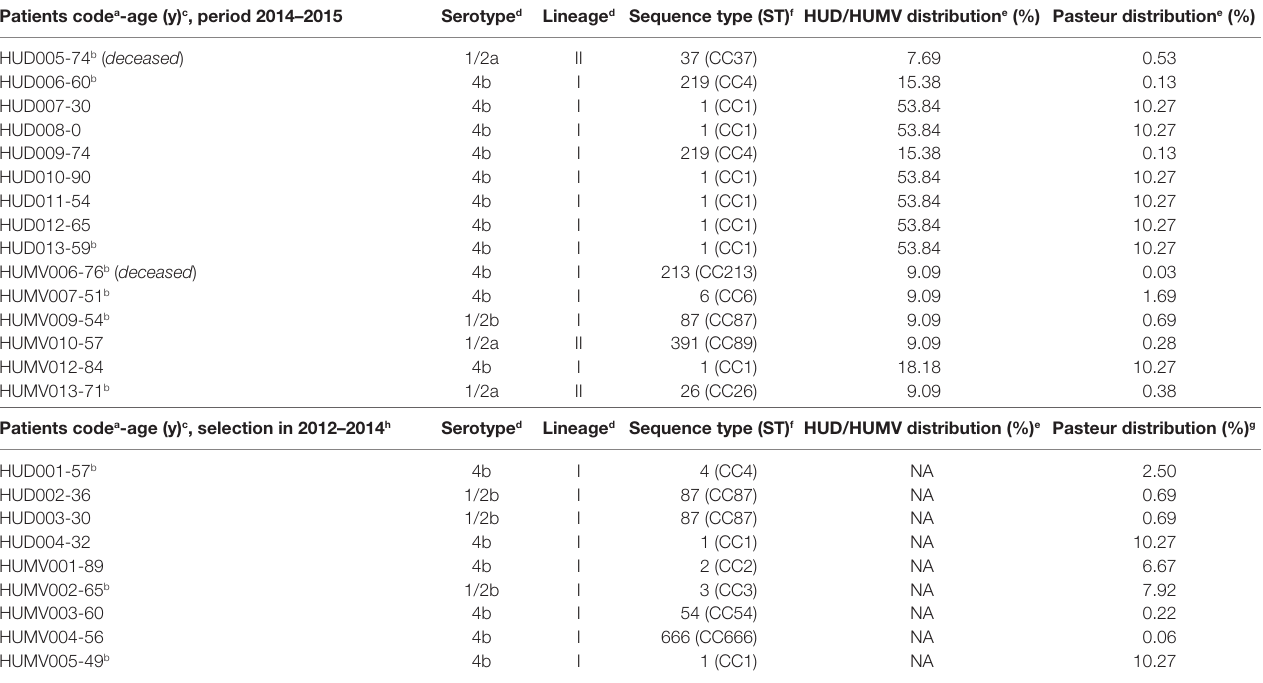
taBLe 2 | Listeriosis patients: microbiological and epidemiological parameters. patients code a -age (y) c , period 2014–2015